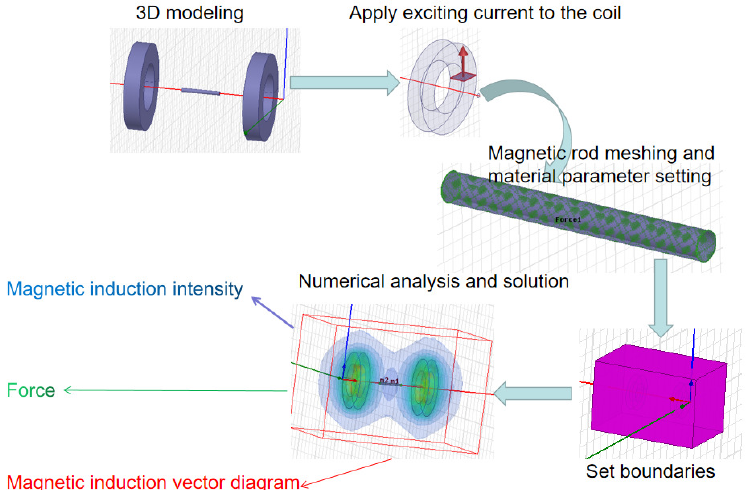
Figure 4. Finite element analysis of magnetic suspension wind tunnel balance (MSBS).